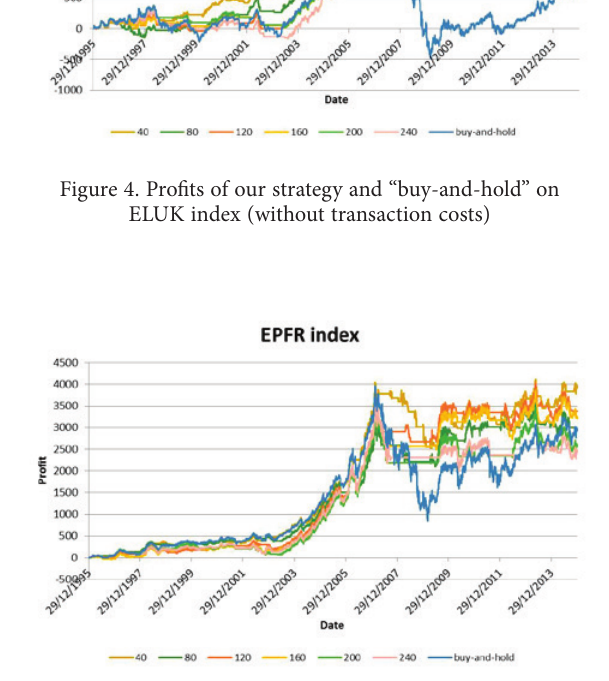
Figure 2. Profits of our strategy and “buy-and-hold” on ELJP index (without transaction costs)